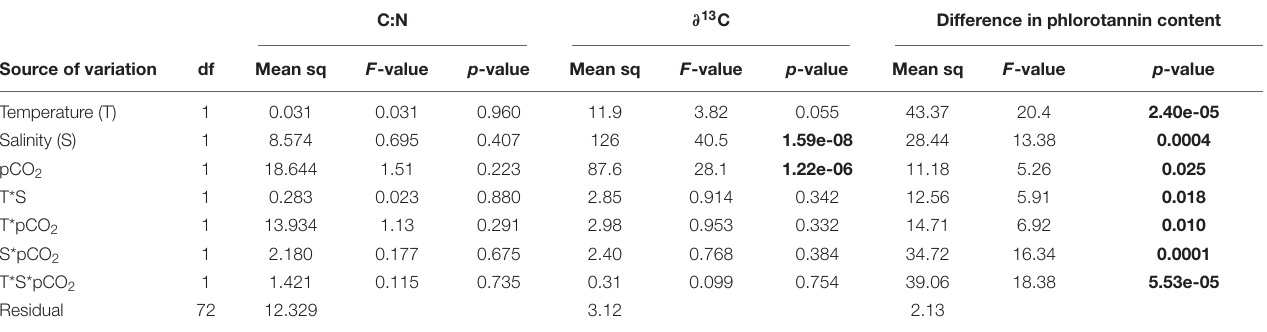
TABLE 3 | Summary of effects of temperature (ambient and high), salinity (ambient and low), and pCO 2 (ambient and elevated) on biochemical composition of Fucus vesiculosus . C:N ∂ 13 C Difference in phlorotannin content